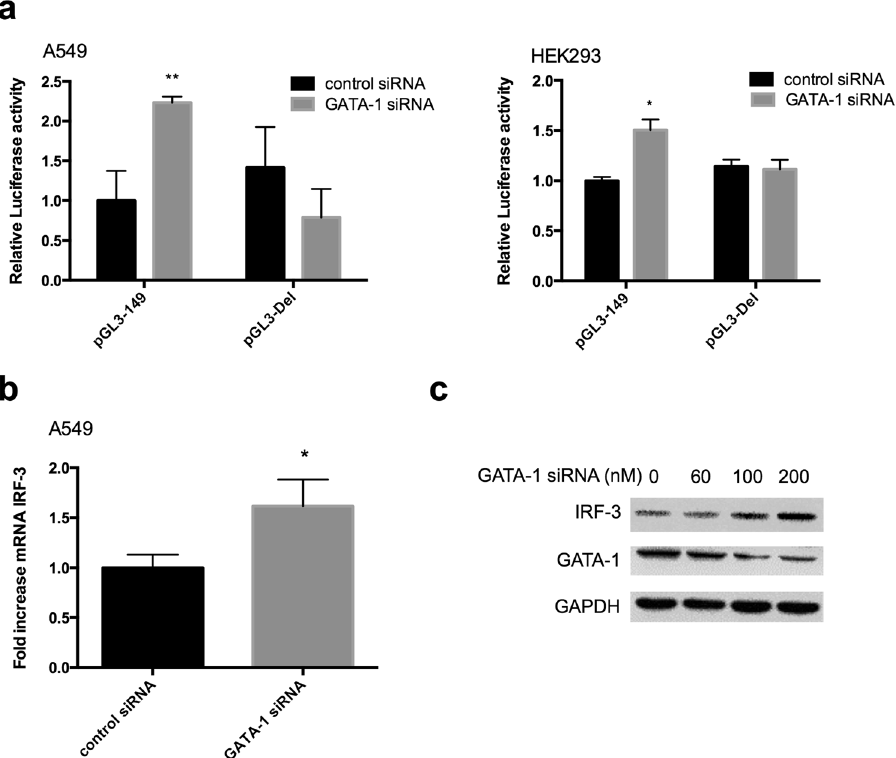
Figure 4. Inhibition of GATA-1 protein expression upregulates IRF-3 transcriptional activity. ( a ) pGL3-149 and pGL3-Del were transfected with GATA-1 siRNA or control siRNA into cells. Relative luciferase activity and ( b ) mRNA expression were detected at 24 h post-transfection. Statistical analyses were done using Student’s-t tests ( * p < 0.05; ** p < 0.01). ( c ) A549 cells were transfected with different dose of GATA-1 siRNA for 48 h. IRF-3 and GATA-1 proteins were analyzed by Western blot. The full-length blots were presented in Supplementary Figure